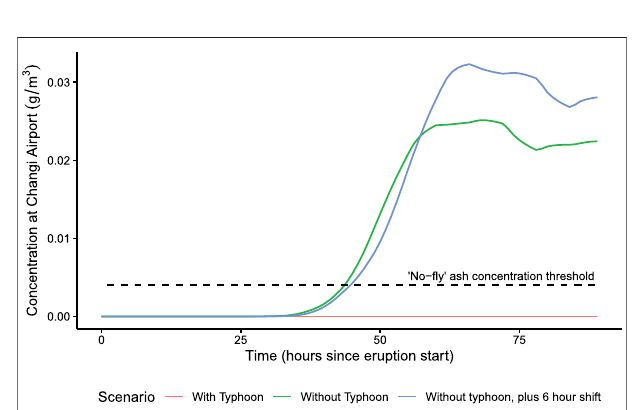
FIGURE7| Variationinground-levelashconcentrationatChangiAirport for three scenarios: the realized With-Typhoon condition, a counterfactual Without Typhoon condition, and the same Without Typhoon condition shifted and additional 6 h in time. The no- fl y concentration of 0.004 g per cubic meter as de fi ned in Zehner (2012) is indicated by the black dashed line.